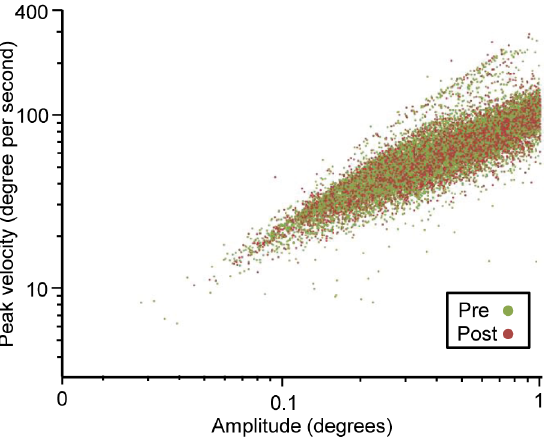
Figure 2. Main Sequence Plot. Comparing amplitude and velocity of eye movements analyzed demonstrates ‘main sequence’ specific to saccadic eye